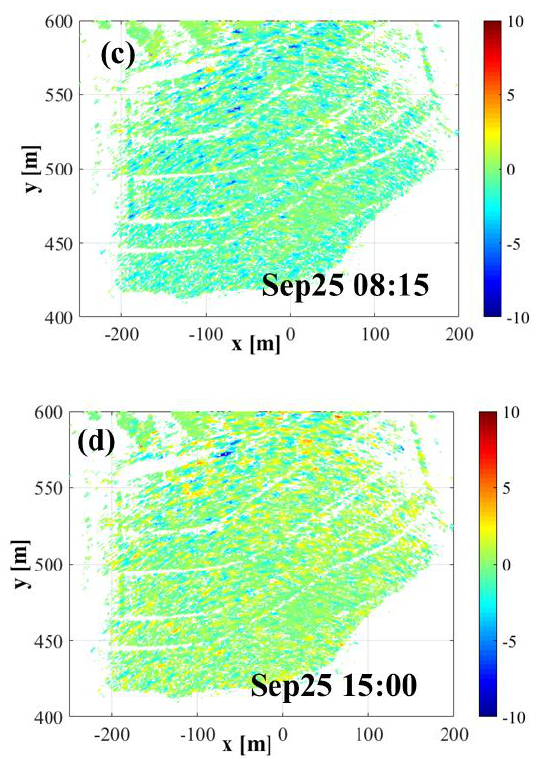
Figure 5. The two-dimensional deformation time series maps of the LSP landslide during the